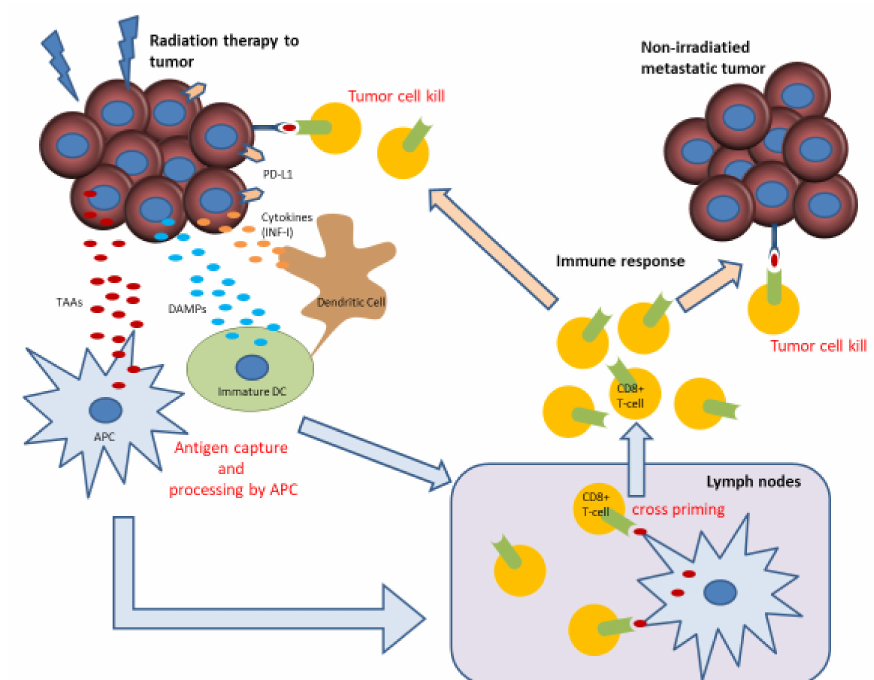
Figure 1. Mechanisms of radiation therapy and immunity (abscopal e ff ect)